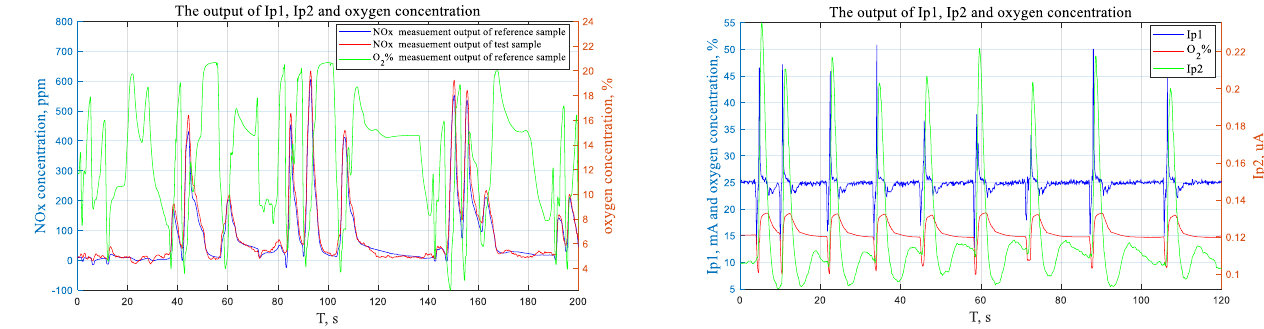
Figure 21. The dynamic output of NOx sensor under driving test.